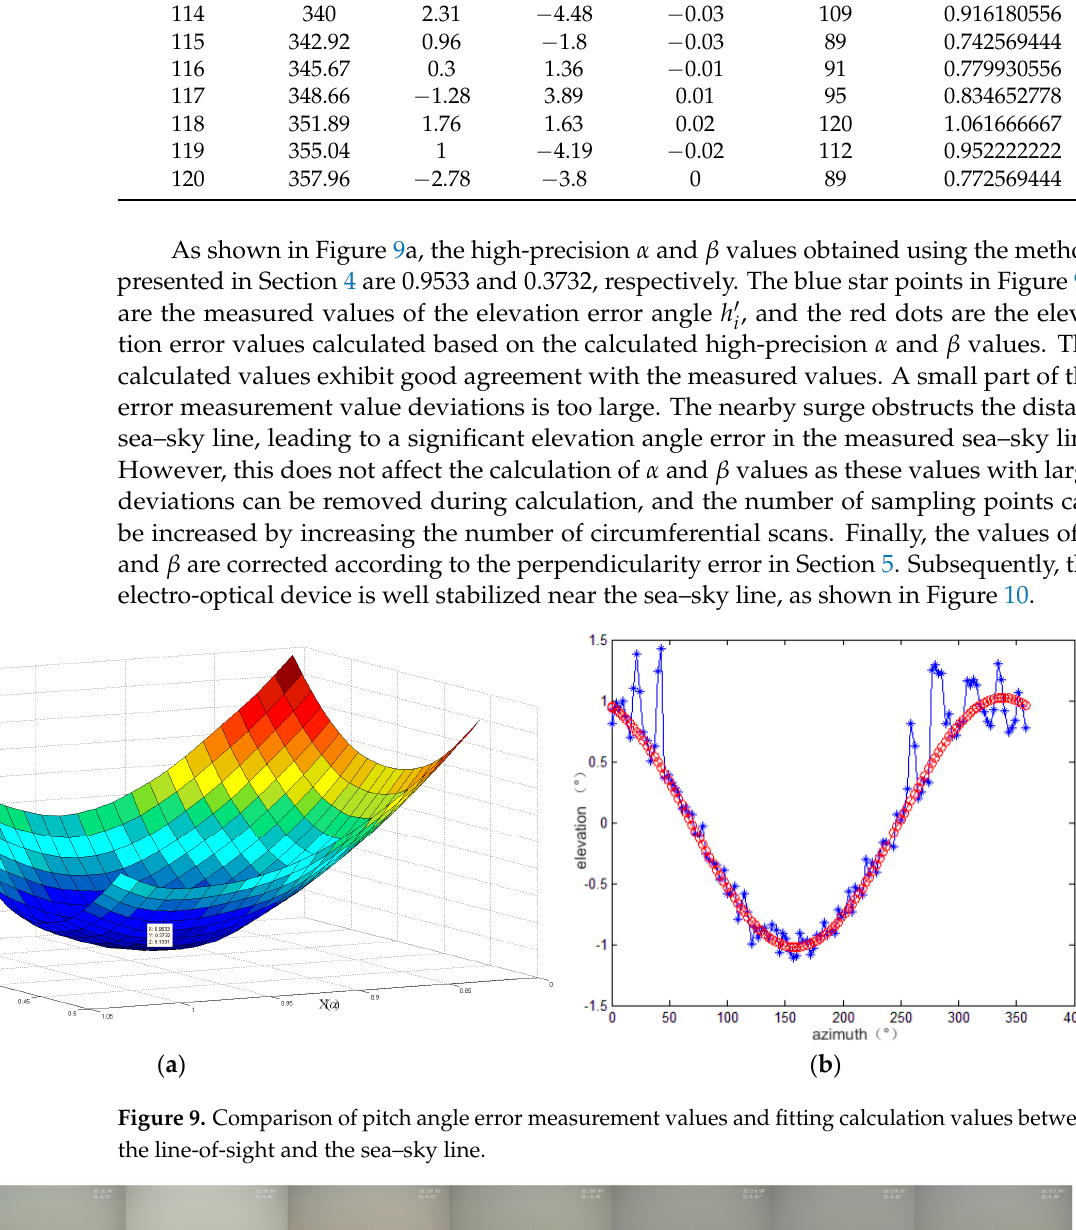
Figure 9. Comparison of pitch angle error measurement values and fi tt ing calculation values be- tween the line-of-sight and the sea–sky line. Figure 10. Circumferential scanning image after the electro-optical device corrects the perpendicular- ity error.